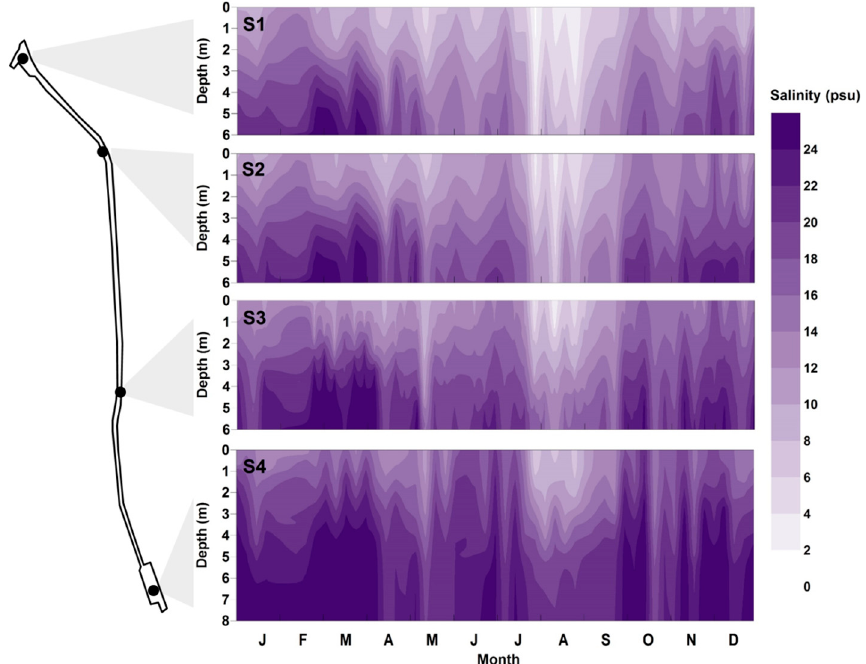
Figure 3. Temporal and vertical distributions of salinity measured at sites S1 − S4.